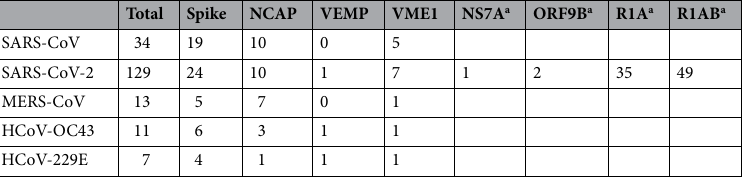
Table 1. Differentially reactive peptides (adjusted p < 0.1, responder frequency ≥ 10%) in COVID-19 convalescent sera (n = 22) when compared to naïve sera (n = 20). NCAP nucleoprotein, VEMP envelope small membrane protein, VME1 membrane protein, NS7A non-structural protein 7A, R1A replicase polyprotein 1a, R1AB replicase polyprotein 1ab. a Peptide microarray only contains peptides from SARS-CoV-2.